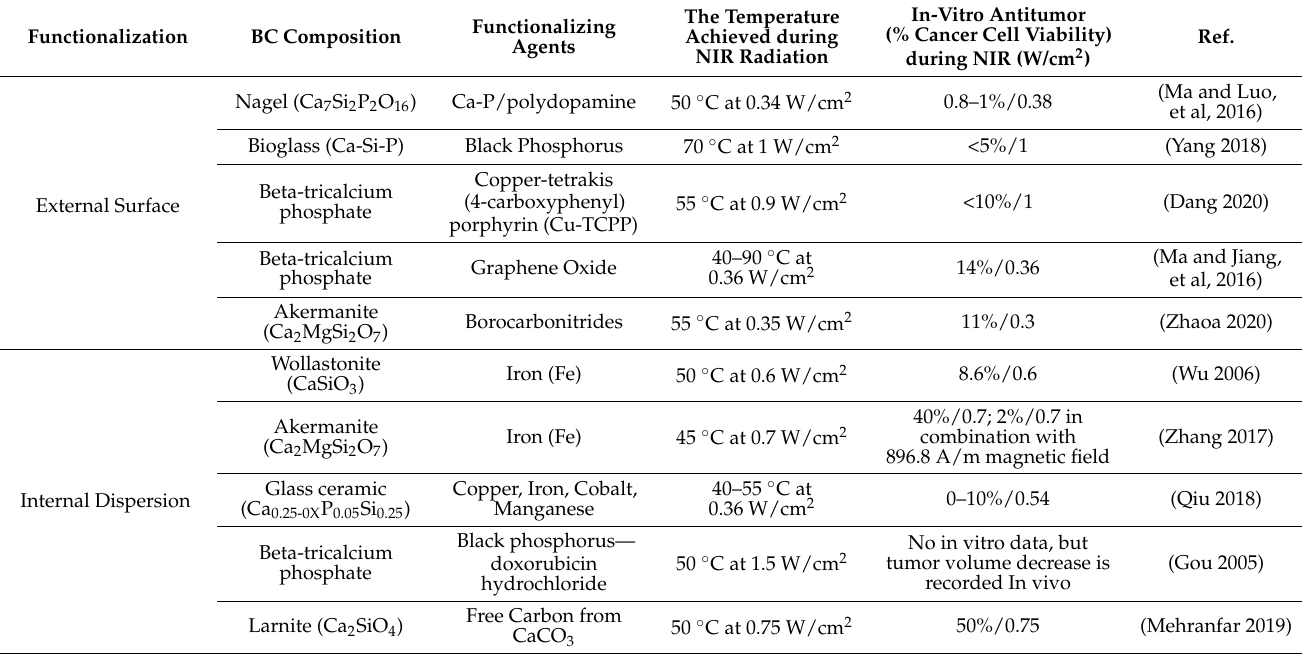
Table 1. Summary of current BC 3D scaffolds with their functionalizing